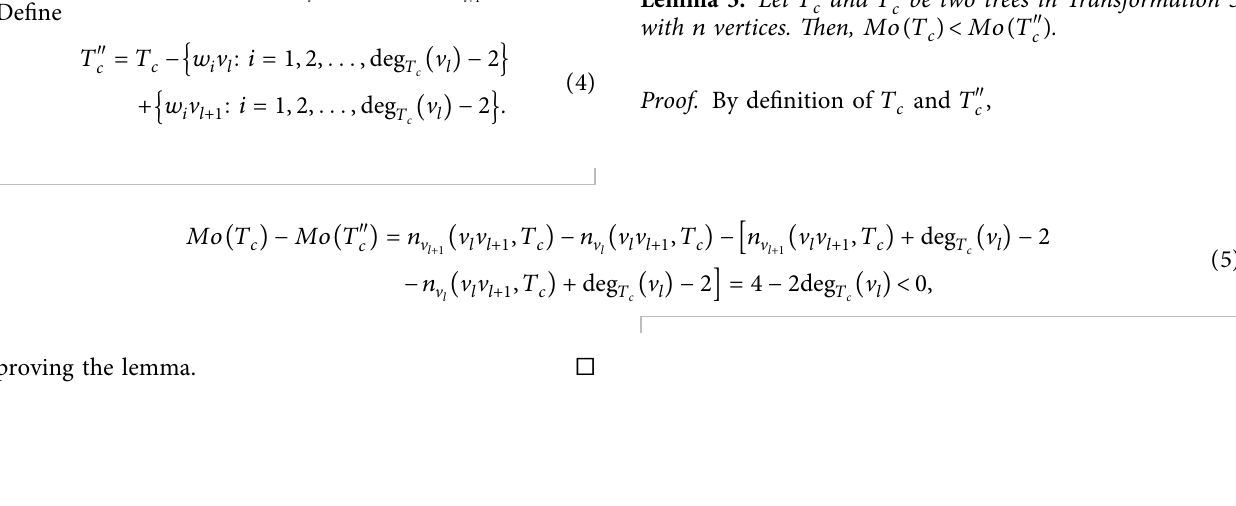
T T ″ in Transformations 2 and c , (b) c ′ , and (c) c